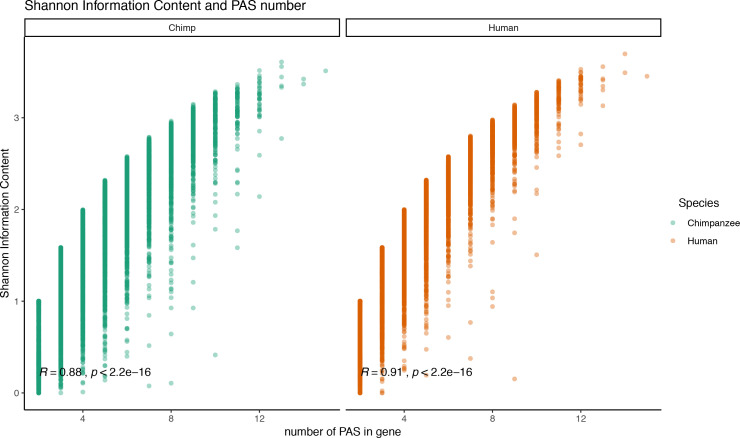
Relationship between Shannon index and polyadenylation sites (PAS) number.Shannon information index plotted against the number of PAS detect for each gene. Pearson’s correlation and significance in black.